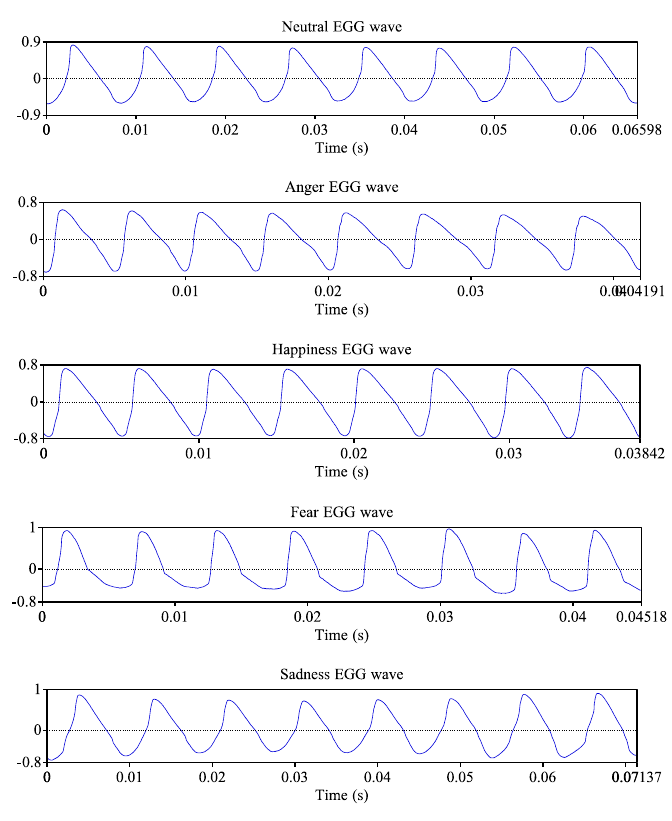
Figure 2. Pitch-normalized EGG waveform of five emotions in English.